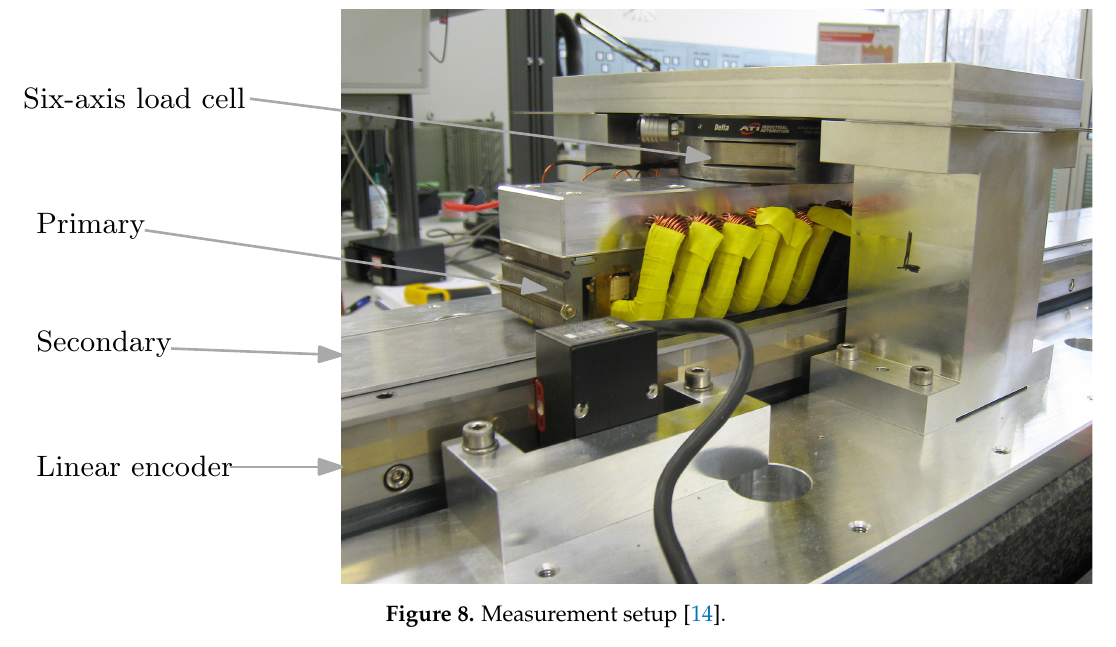
Figure 8. Measurement setup [14].